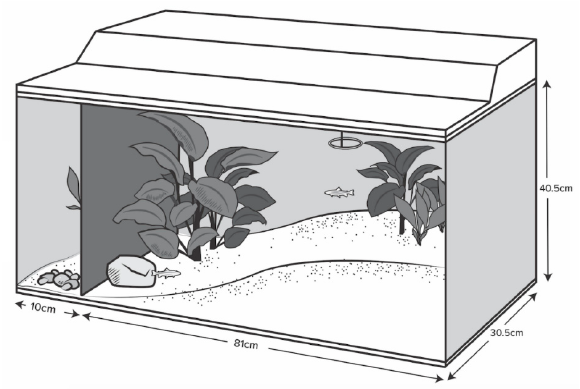
Figure 1. Diagram of 110 L semi-natural tanks. Circle at top right indicates location of the feeding ring (adapted from Reference [16]). Note inaccessible area at left (10 cm wide).